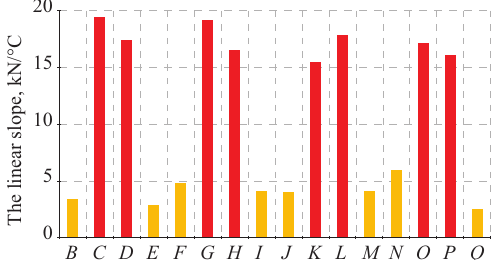
Figure 15. The linear slopes of different splice